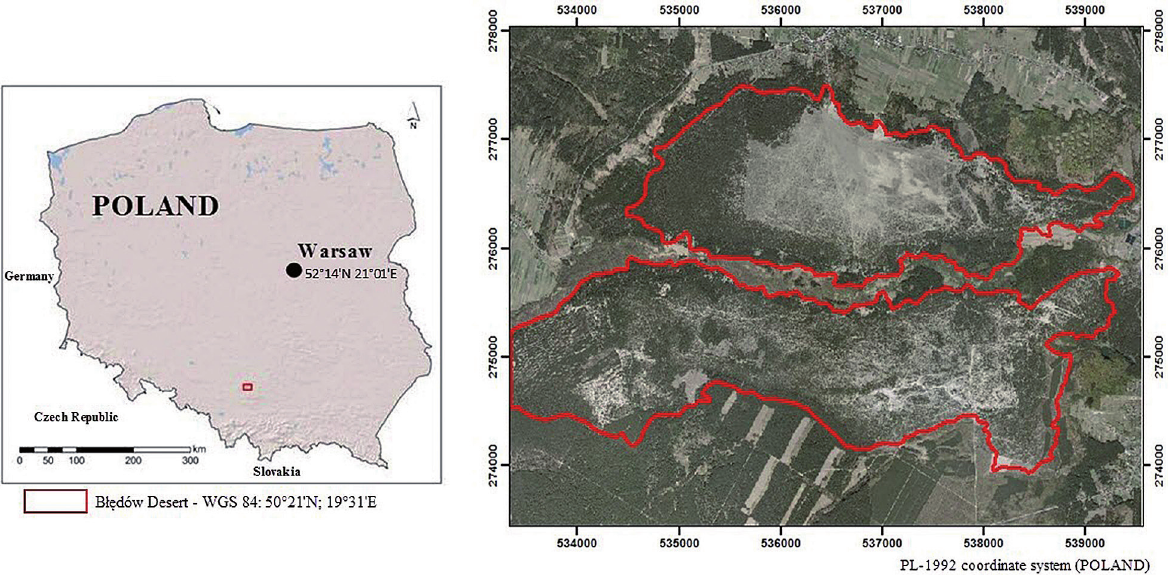
Fig. 1. The area under study (left – red rectangle; right – the enlarged